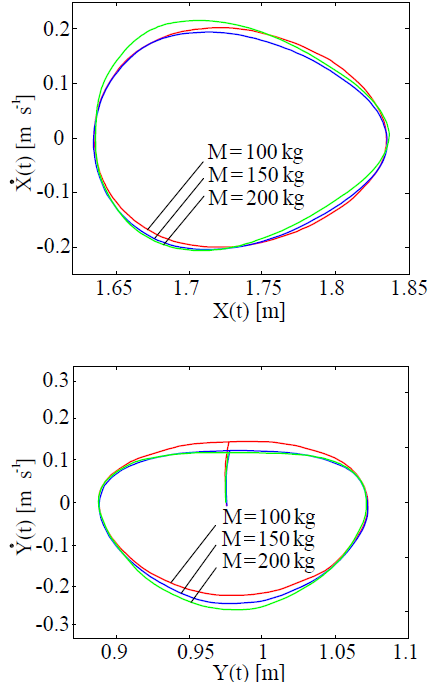
Figure 27. Phase trajectories the motion of a joint, connecting working platform with link in different values of load mass and with the coefficient of rotational friction of k = 0 .